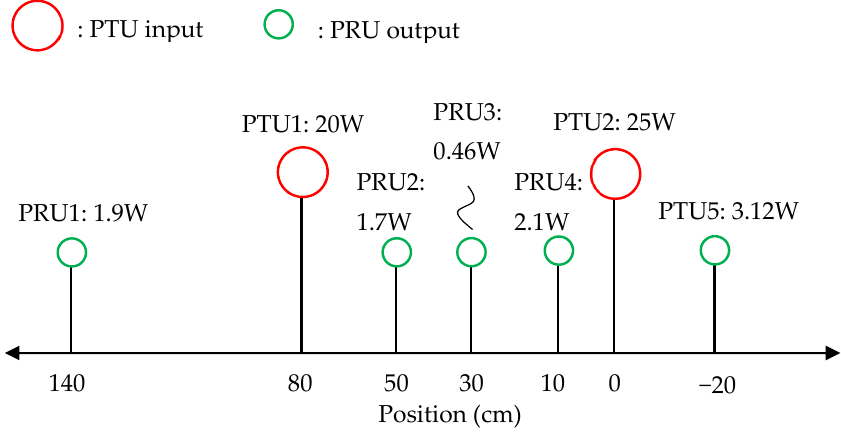
Figure 23. PDL of MIMO applications.